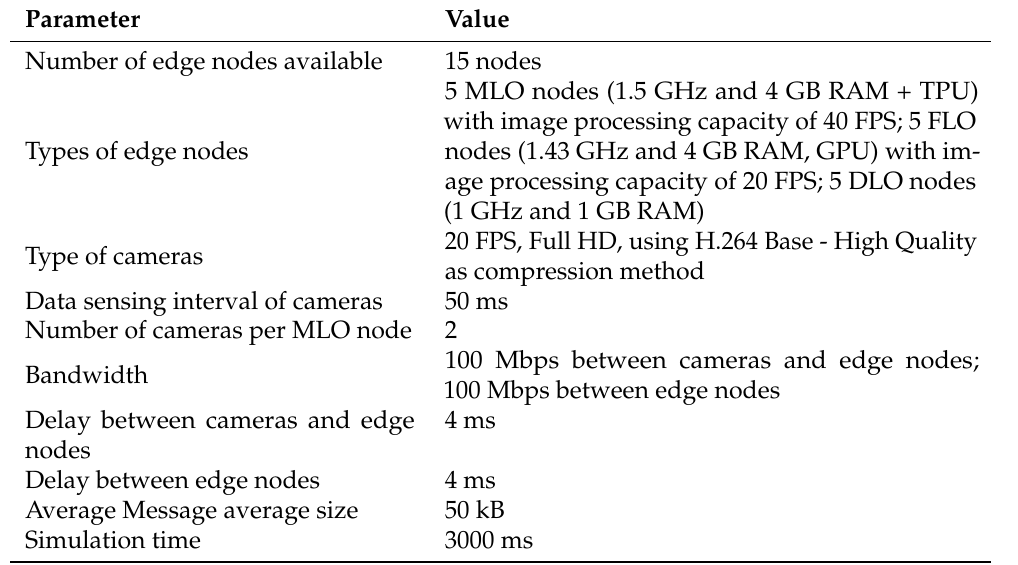
Table 3. Simulation